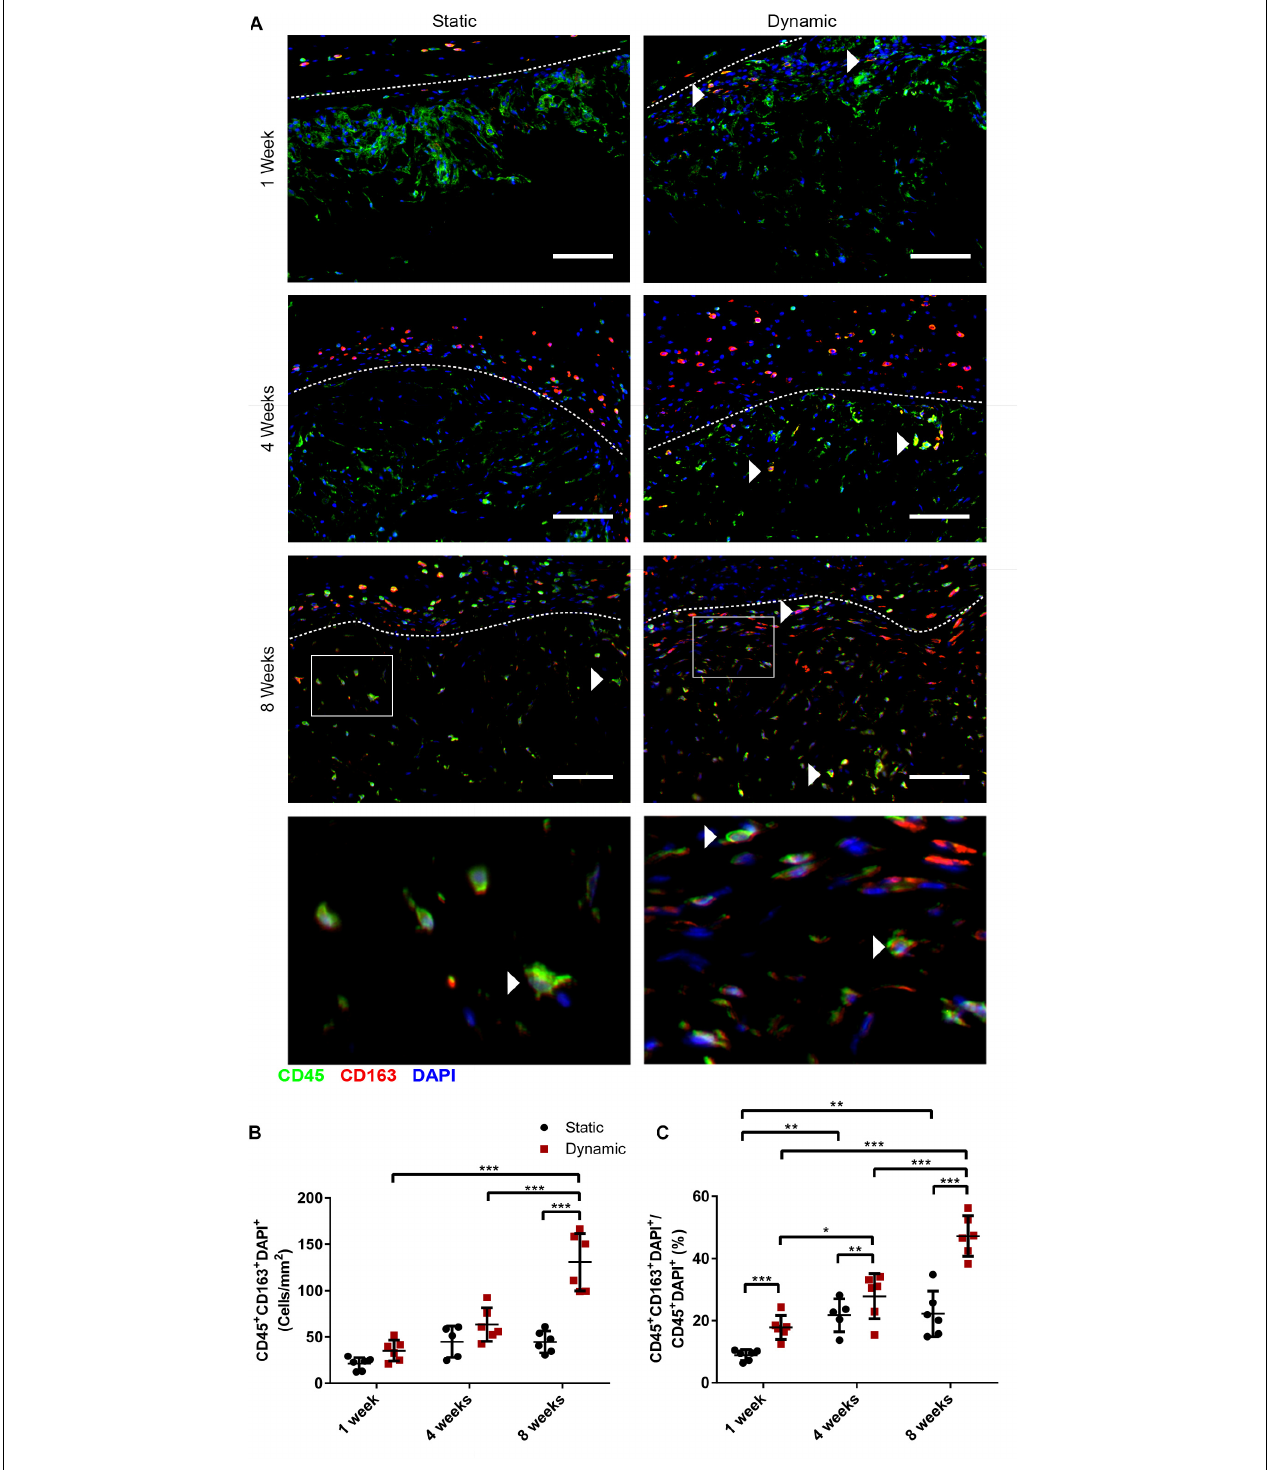
FIGURE 7 | Dynamic culture of human ASCs on the DAT scaffolds enhanced the percentage of cells expressing the pro-regenerative macrophage marker CD163 in the CD45 + host cell population at 8 weeks post-implantation in the nu/nu mouse model. (A) Representative images showing CD45 (green), CD163 (red), and DAPI (blue). Dashed lines indicate the border between the fibrous capsule (top) and the DAT implant (bottom) . Scale bars represent 100 µ m. Boxed regions in the 8-week images are shown at higher magnification below. White arrowheads highlight CD45 + CD163 + cells. (B) CD45 + CD163 + DAPI + cell density within the DAT implants. (C) The percentage of CD45 + CD163 + DAPI + cells relative to the total CD45 + DAPI + population. * p < 0.05, ** p < 0.01, *** p < 0.001.